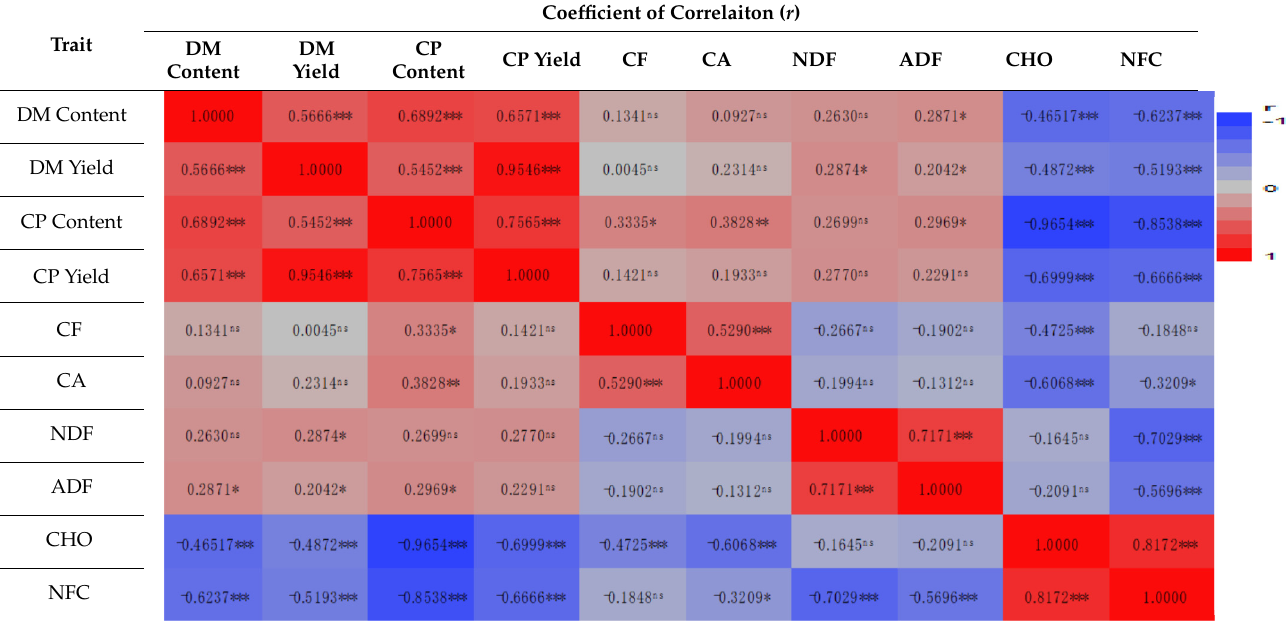
Table 5. Heatmap of correlation matrix between evaluated traits.